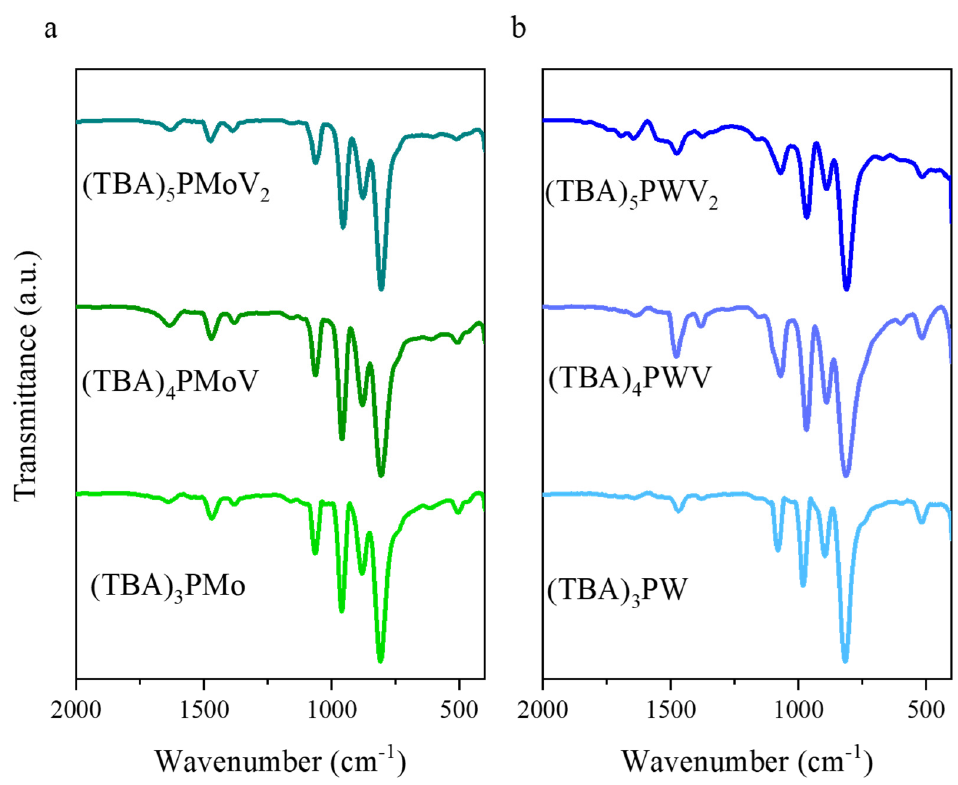
Figure 2. FT-IR spectra of pure and V-substituted Mo ( a ) and W ( b ) Keggin-type polyoxometalates TBA salts.